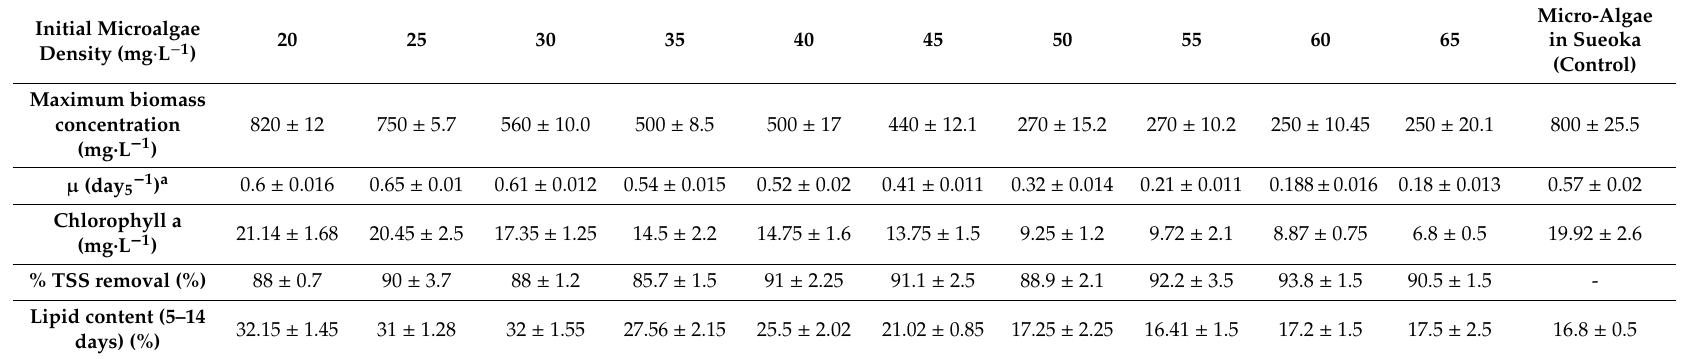
Table 1. The characteristics of Chlorella vulgaris inoculum in